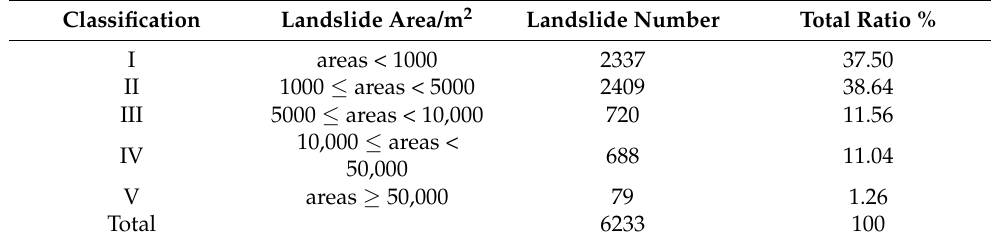
Table 1. Distribution characteristics of coseismic landslides in different